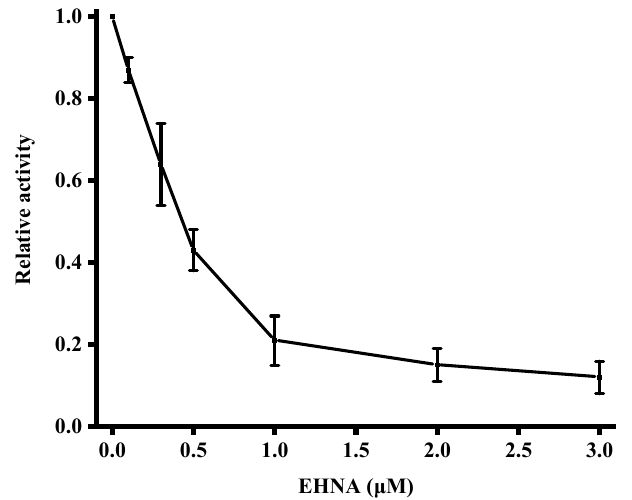
Figure 6. Variance of relative activity of ADA in response to different concentrations of EHNA. Error bars were estimated from three replicate measurements.